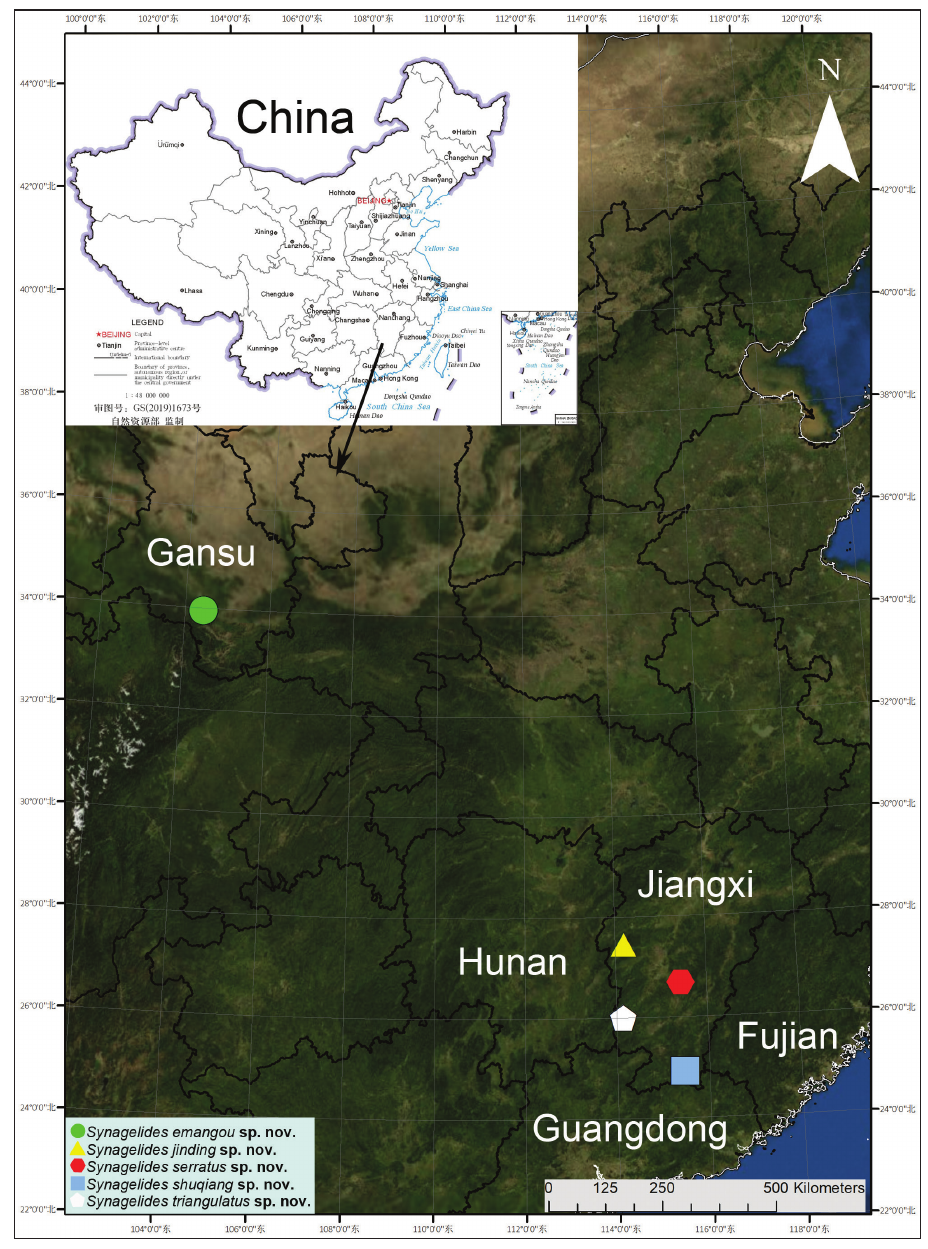
Figure 13. Records of Synagelides emangou sp. nov. from Gansu province; S. jinding sp. nov., S. serratus sp. nov., S. shuqiang sp. nov., and S. triangulatus sp. nov. from Jiangxi Province in Epigyne (Fig. 12C, D). Epigynal plate apple-shaped, with a triangular median septum. Epigynal hood broadly bell-shaped, arising from anteromedial atrial rim. Atrium relatively large, separated by the median septum. Atrial rim round, slightly sclerotized. Copulatory